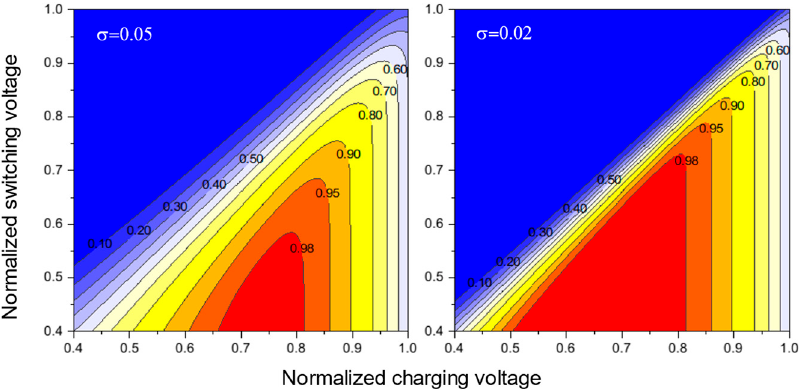
Figure 6. Scattering of switch voltage and combination of charging voltage and switch voltage affect PFL reliability.